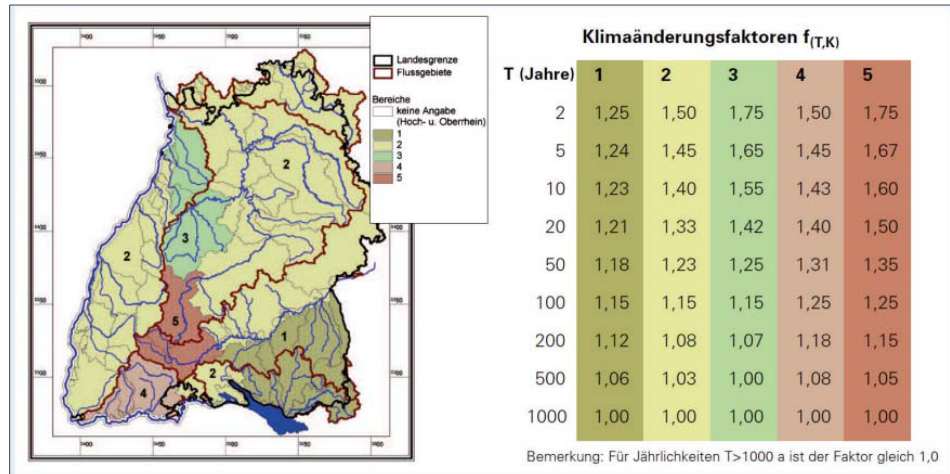
Figure 2. Climate Change Factors table for Baden ‐ Württemberg, indicating catchments (in the columns numbered 1–5) and annuality (in the rows indicating probability of recurrence in years), (KLIWA 2004).